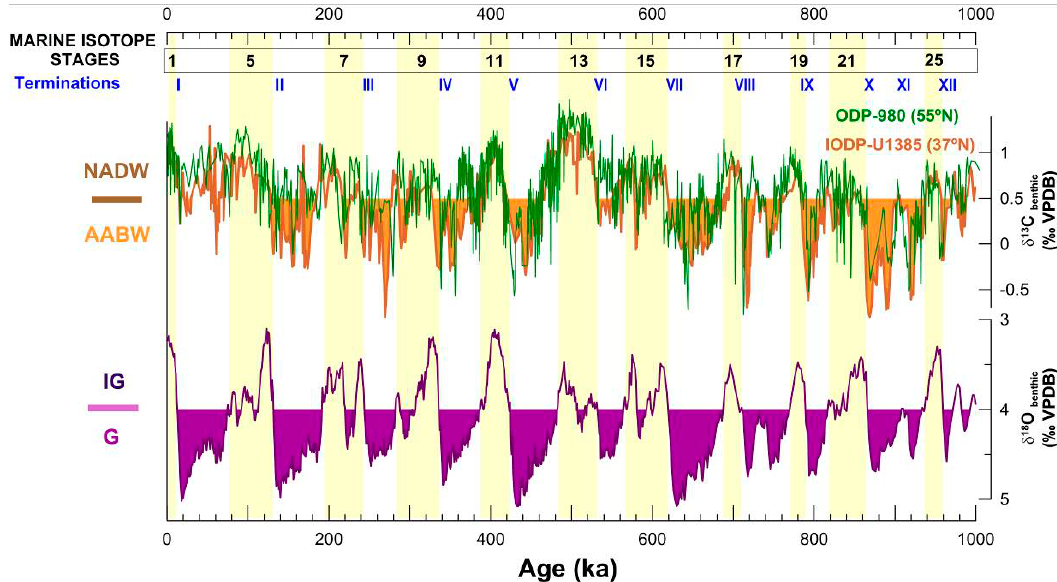
Figure 8. Atlantic meridional overturning circulation (AMOC) rate and origin of the deep water mass in the North Atlantic (northern-sourced NADW or southern-sourced AABW) along Pleistocene. In purple, δ 18 O [10] indicates ice volume; the fill shows the glacial/interglacial threshold. In brown, benthic δ 13 C from the mid-latitude site U1385 (37°34´ N; 10°7´ W; 2589 m depth) [79]; orange fill shows δ 13 C values for AABW. In green, δ 13 C from the sub-polar site 980 (55°29´ N; 14°42´ W; 2168 m depth) [36]. Site 980 generally registers higher δ 13 C than site U1385 because the surface water sinks in this region to form NADW. The exceptional events when δ 13 C is lower in 980 than in U1385 occur as consequence of the migration of the sinking area south from site 980.